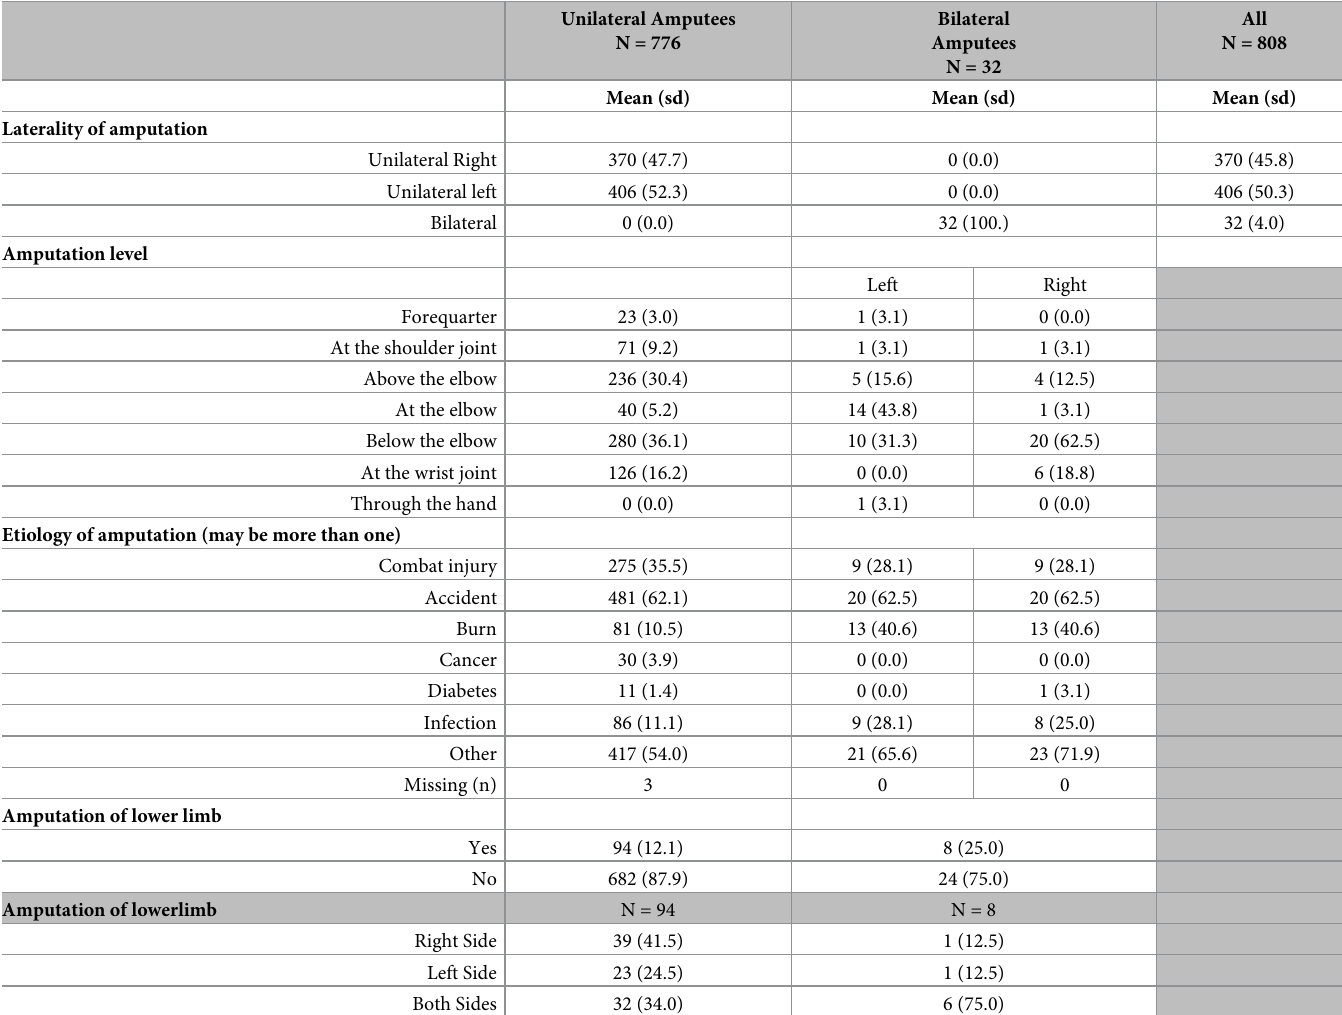
32.8% reported that they received their most recent device more than 4 years prior. In contrast 41% of bilateral amputees had received at least one of their devices within the past 2 years (21% within the prior year). Thirty seven percent of unilateral amputees reported that they used 2 or more prostheses, and 24% of bilateral amputees used 2 or more prostheses for at least one side. Body powered devices were the most common primary prosthesis type used (70.9% unilateral amputees, 79% bilateral left and right sides). Forty-three percent of unilateral amputees reported that they used two or more types of ter- minal devices, as compared to about 14% of bilateral amputees who used two or more terminal devices on at least one side. The most common types of primary terminal devices were body powered hooks (unilateral: 62%, bilateral: 72% left, 74.0% right. Multi-degree of freedom ter- minal devices (including the I-limb, Michaelangelo Hand and Bebionic) were used by 10.8% of unilateral amputees and 0% of bilateral amputees. The most prevalent suspension methods were self-suspending (75.2% unilateral, 84.0% left and 81.5% right bilateral), followed by gel